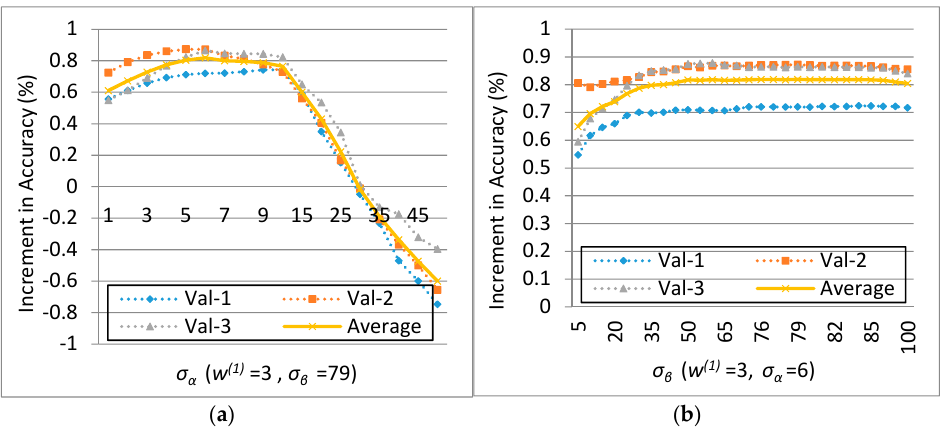
σ ) on the final σ ) on the final σ . σ .